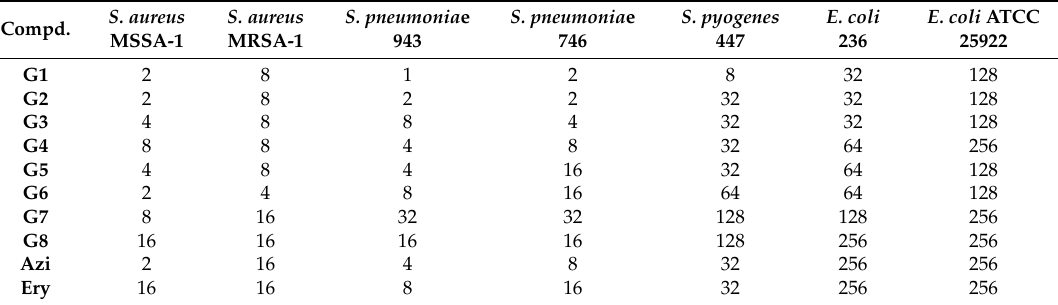
Table 1. Antibacterial activities of the title compounds in vitro (MIC, µ g/mL).